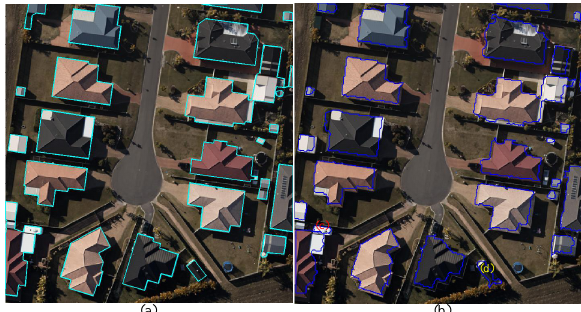
Figure 9. (a) Hervey Bay reference data set, (b) Detected build-